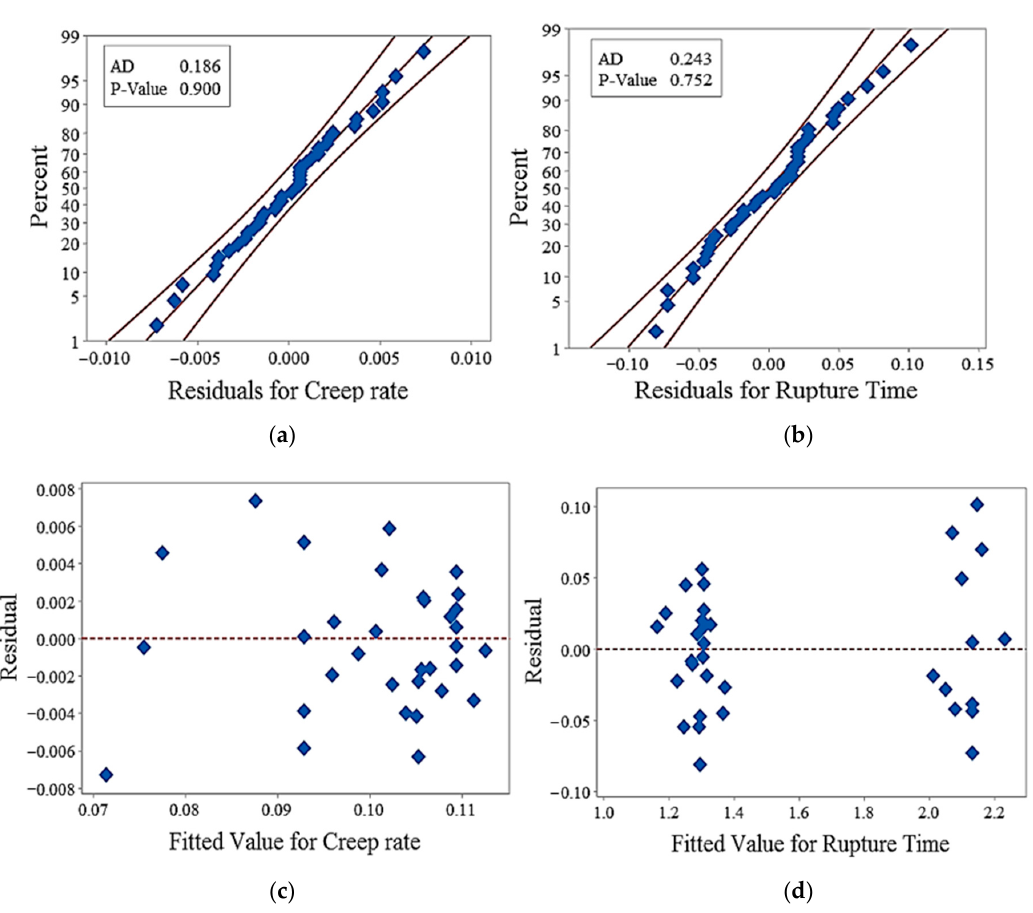
Figure 5. ( a ) Normality plot for creep rate. ( b ) Normality plot for rupture time. ( c ) Residual distribution for creep rate. ( d ) Residual distribution of rupture time.